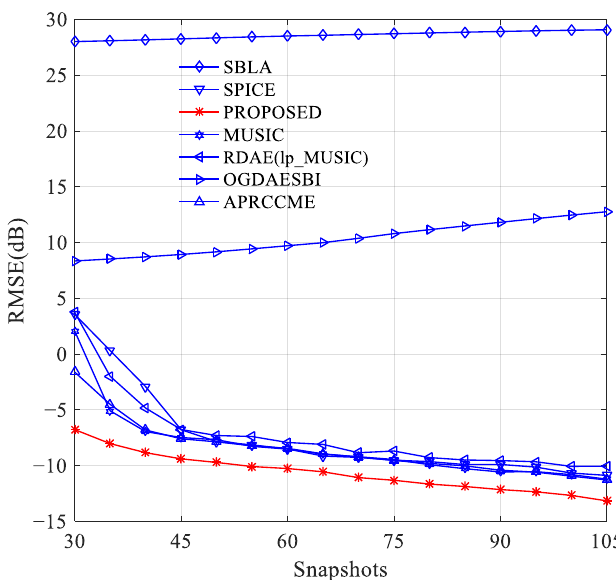
Figure 6. RMSE versus the number of snapshots.